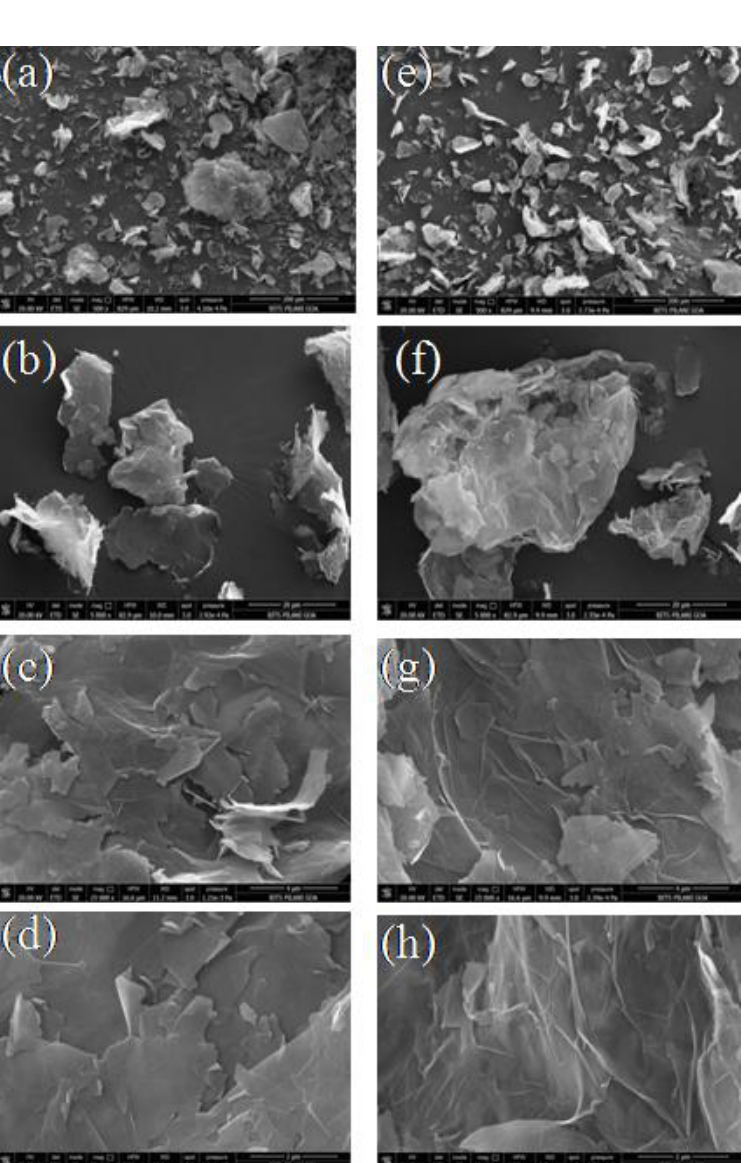
Figure 1. Field emission scanning electron microscope (FESEM) images of GNPs for each grade: ( a – d ) H25 and ( e – h ) M25 at 500× ( a , e ), 5000× ( b , f ), 25,000× ( c , g ) and 50,000× ( d , h ) magnifications. ( a – d ) H25 and ( e – h ) M25 at 500 × ( a , e ), 5000 × ( b , f ), 25,000 × ( c , g ) and 50,000 × ( d , h )